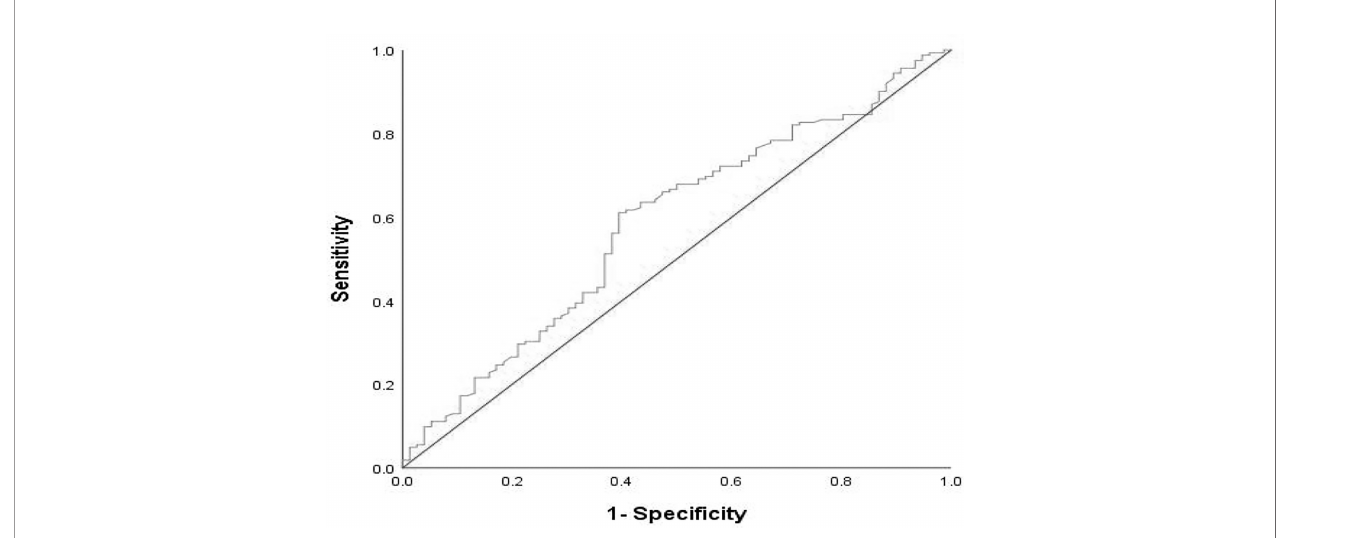
FIGURE 1 | ROC curve of pretreatment dNLR in assessment of the disease progression rate at the 8th month. Sensitivity:61.1%; Speci fi city:60.5%; AUC:0.584; p = 0.037. dNLR, derived neutrophil – lymphocyte ratio; ROC, receive operating characteristic; AUC, areaunder the